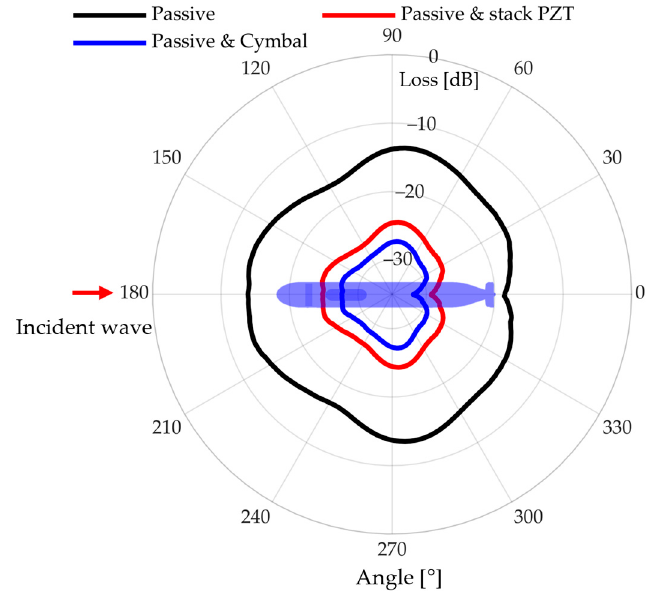
Figure 15. Result of modeling the omnidirectional effect of the active reflection control system- only passive attenuation applied (black), cancellation effect by cymbal transducer (blue), cancellation effect by stack PZT (red). Table 3. Absorption effect of UUV active reflection control simulation using multi-layer transducer. Center